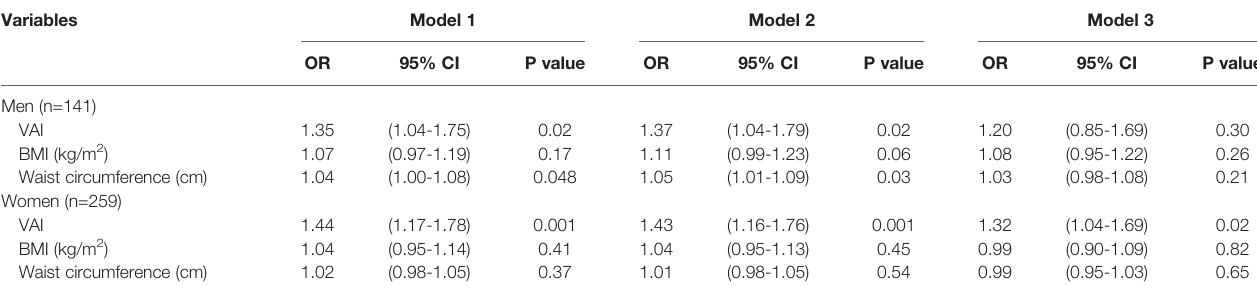
TABLE 3 | Multivariate logistic regression analysis of different obesity indices associated with the risk of CKD in men and